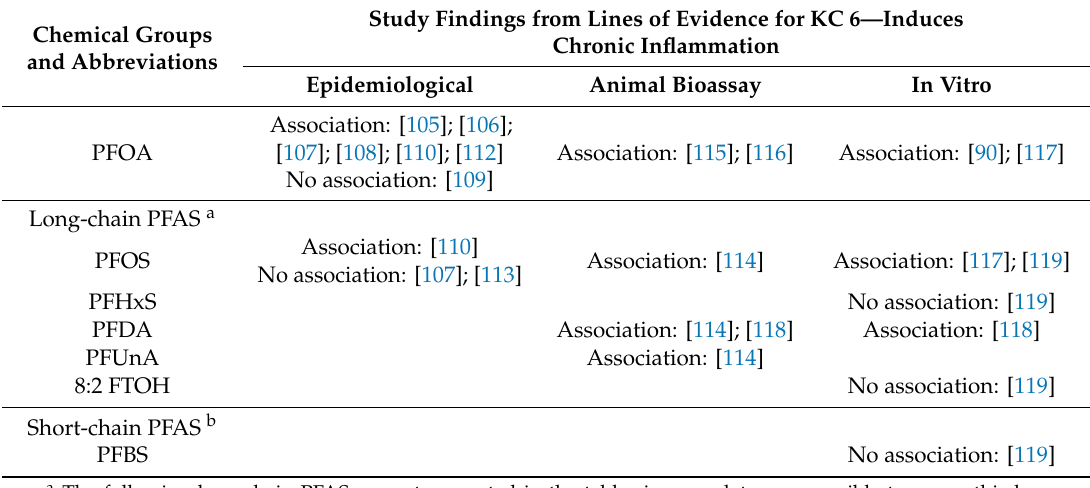
Table 5. Chemical specific study findings for key characteristic six—induces chronic